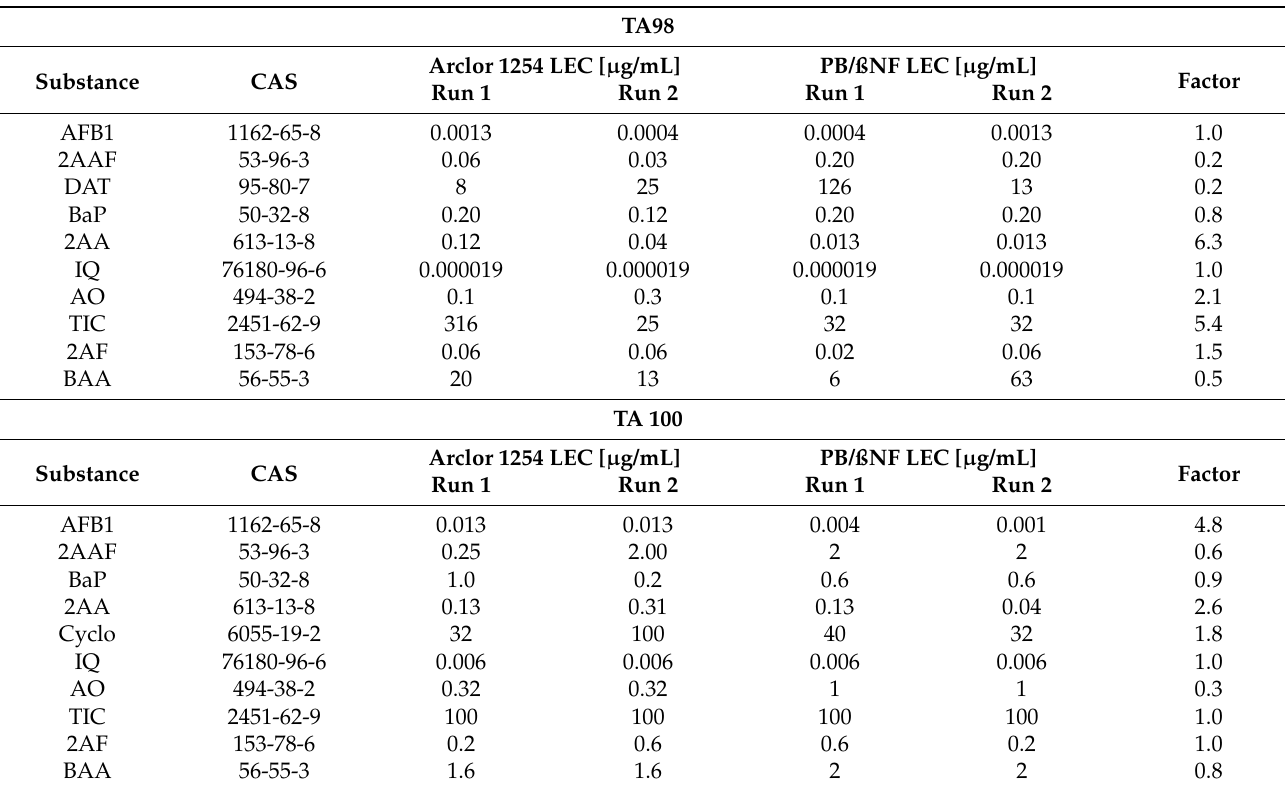
Table A3. Individual results of two independent test runs in the Ames MPF assay with PB/ßNP-induced S9 vs. Aroclor 1254-induced S9. LECs are presented in µ g/mL in the exposure medium. The factor is calculated by dividing the mean LEC of the results obtained with Aroclor 1254 by the results obtained with PB/ β -NP-induced